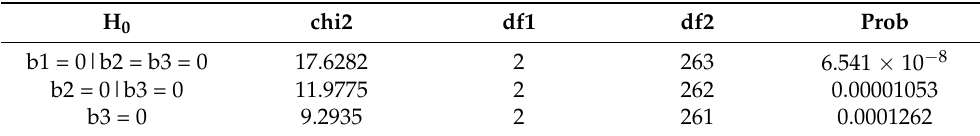
Table 5. Terasvirta sequential